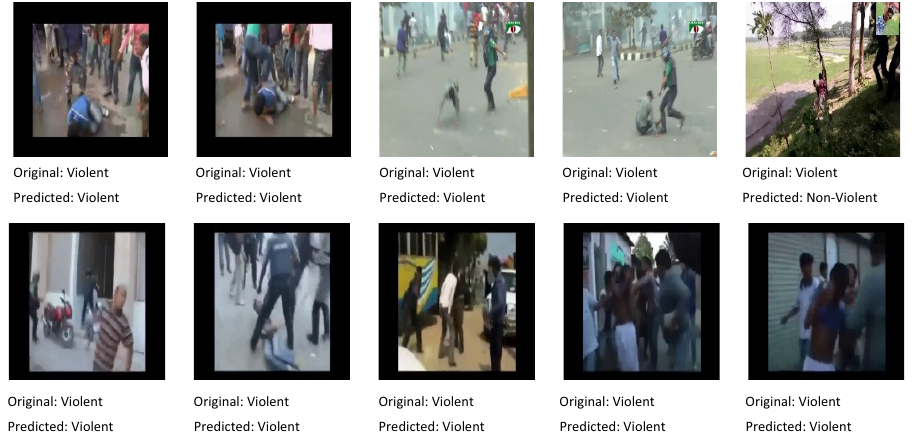
Fig. 18. Prediction on violent video frames.